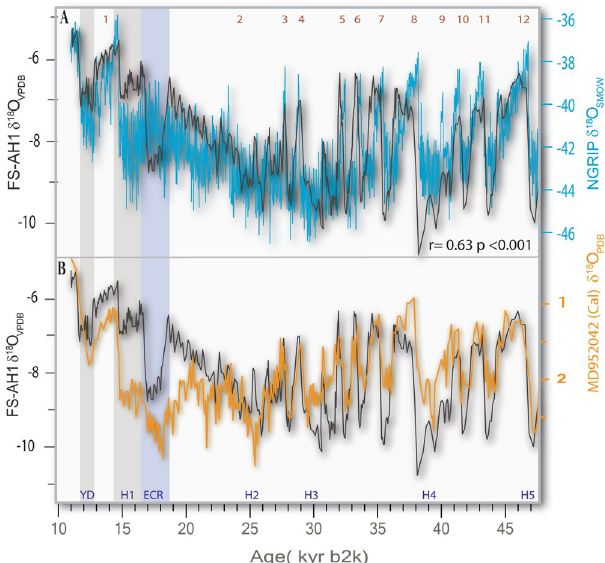
Figure 2. ( A ) Comparison of stalagmite FS-AH1 δ 18 O time-series (black line) and the Greenland ice-core NGRIP δ 18 O time-series on GICC05 chronology 5 . There is a remarkable match between the FS–AH1 δ 18 O time- series and ice core δ 18 O time-series, both with respect to long-term trends and millennial-scale rapid (FS-AH1 δ 18 O and NGRIP is r = 0.63, p < 0.001) A distinct cold reversal, which we are calling the Extrapolar Climate 2t Reversal (ECR) is shown as blue bar. ( B ) The marine core MD95-2042 δ 18 O time-series from the Iberian margin 25, 26 tuned to the FS-AH-1 chronology (Fig.